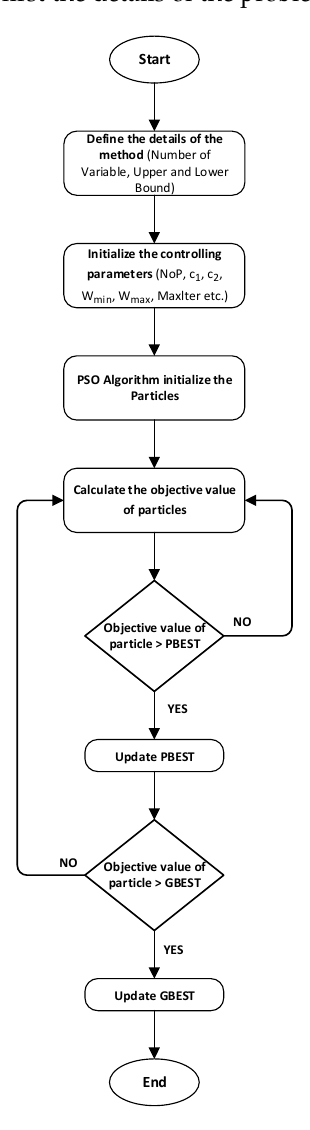
Figure 9. PSO flowchart.